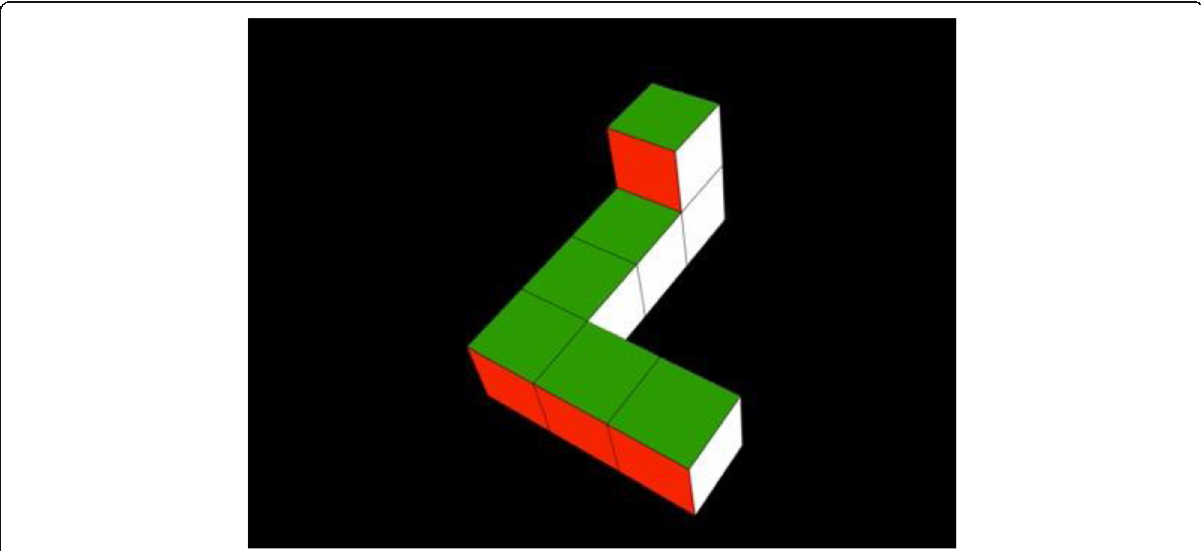
Fig. 1 Stimulus object used in Christodoulou, Johnson, Moore, and Moore (2016), Constantinescu, Moore, Johnson, and Hines (2018), Heil, Krüger, Krist, Johnson, and Moore (2018), Moore and Johnson (2008, 2011), and Slone, Moore, and Johnson (2018). Infants were habituated to a video of this object — or its mirror-image — rotating back and forth on its vertical axis through a 240-degree angle. After habituation, infants were tested with a video showing this object (or its mirror-image) rotating back and forth on its vertical axis through the previously unseen 120 degrees of arc. Adapted from Moore and Johnson (2008), Fig. 1